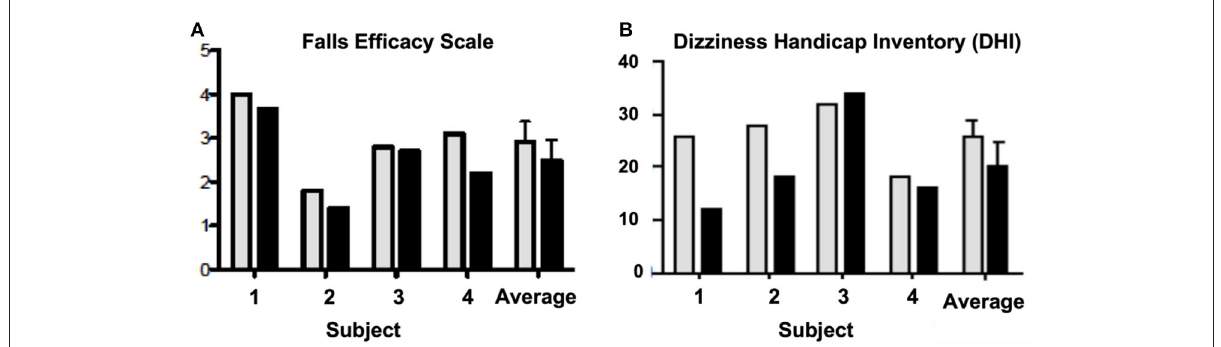
FIGURE1 Pre-test (gray) and post-test (black) scores on the (A) Falls Efficacy Scale (47) and the (B) Dizziness Handicap Inventory (DHI) (48) for each subject. The last two columns on each graph are the average scores + SD across all four subjects for the pre- and